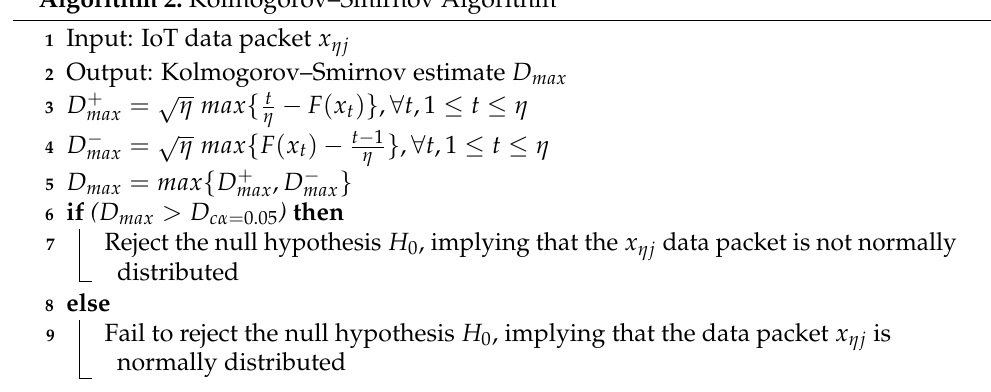
Algorithm 2: Kolmogorov–Smirnov Algorithm